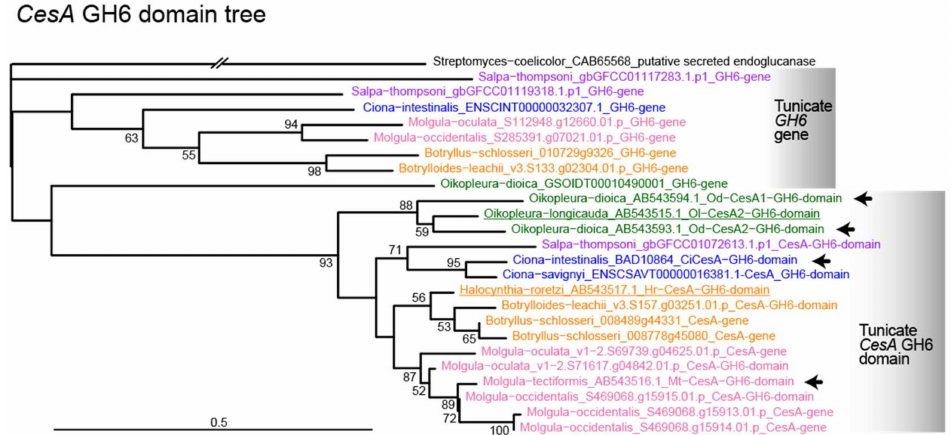
Figure 3. Molecular phylogenic tree of the GH6 domain obtained using ORTHOSCOPE analysis (438 nucleotide sites). The GH6 domains of four CesA genes of three tunicates (indicated with arrows) were used as query sequences. The Streptomyces gene (CAB65568) was selected for tree rooting. Because all the non-tunicate metazoans examined do not contain GH6 orthologs, the tree includes only tunicates. It should be noted that tunicate genomes contain not only CesA genes, including the GH6 domain, but also another tunicate-specific GH6